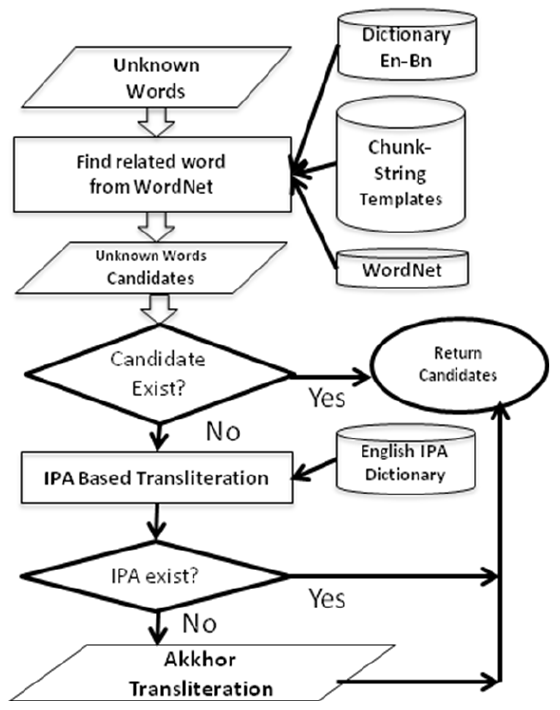
Fig. 6 Steps of handling unknown